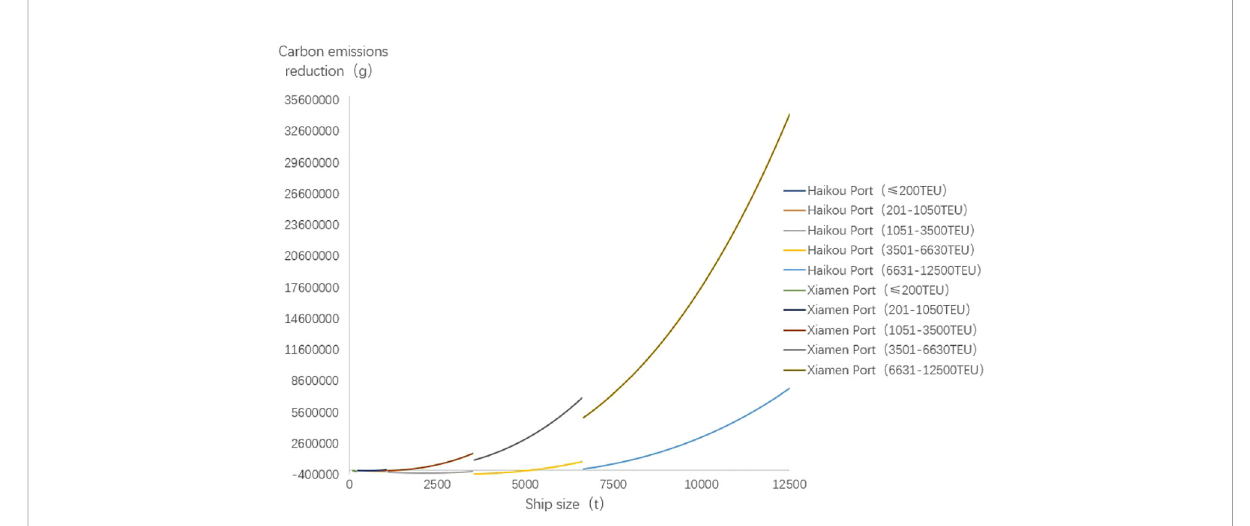
FIGURE 2 The relationship between carbon emission reduction and ship